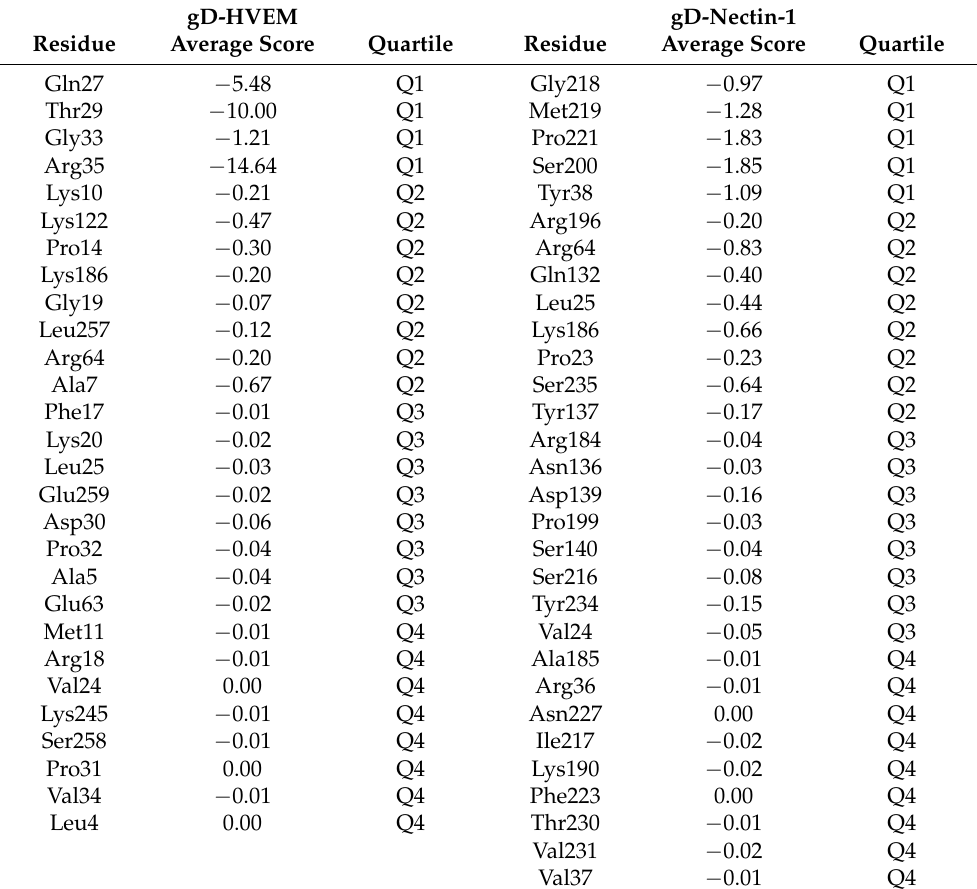
For both protein–protein complexes, 100 frames extracted by MDs were adopted to cal- culate the relative binding free energy ( ∆ Gbind) using Molecular Mechanics/Generalized Born Surface Area (MM/GBSA) methodology, as applied in a recent study [39]. The results of the calculated ∆ Gbind trend for gD-HVEM and gD-Nectin-1 are depicted in Figure 5. Even showing a similar energy profile, the average values of − 134.36 and − 138.26 kcal/mol were turned out for HVEM and Nectin-1 in complex to gD, respectively, thus resulting in a more stabilizing effect of gD towards Nectin-1.